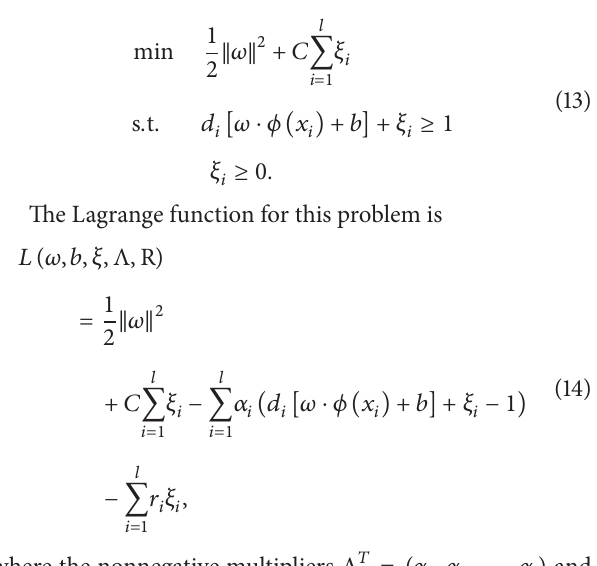
Figure3:Aclassificationexampleinatwo-dimensionalspacebased on SVM [27,